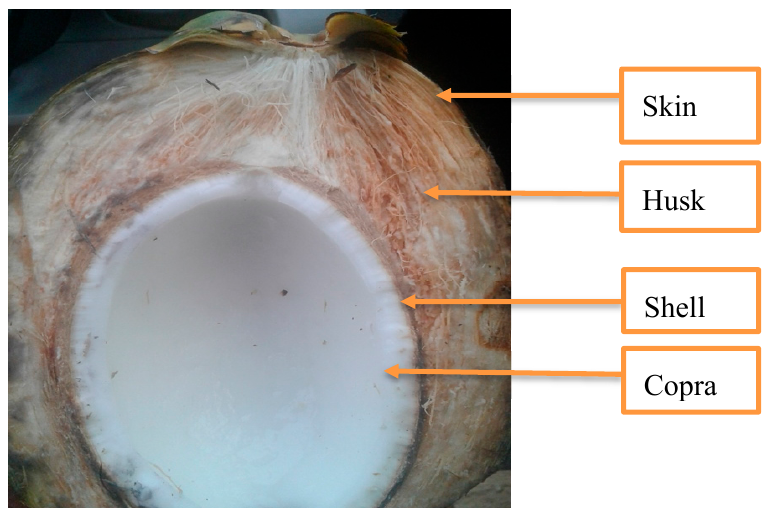
Figure 2. Half view of whole coconut showing the husk, skin, shell and copra.